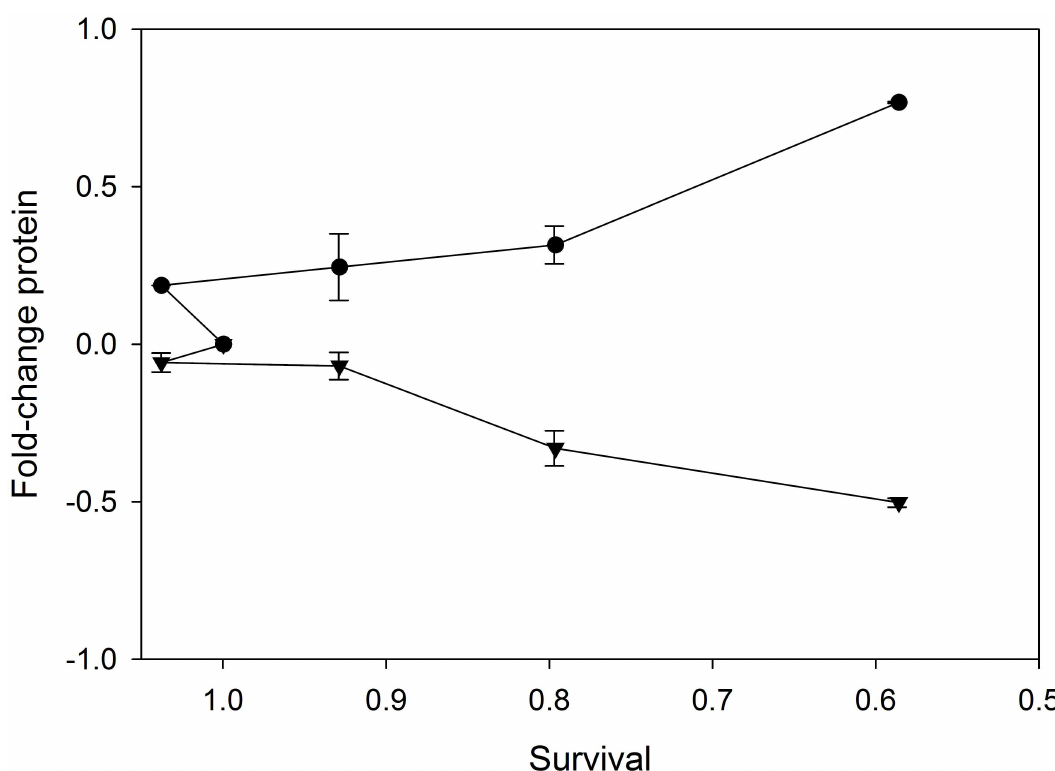
Fig 3. Relative cell survival (X-axis) vs. protein expression or phosphorylation levels (Y-axis)in BEAS-2Bcontrol cellstreatedwithNi (II)at 4 differentconcentrations. ● : IL-6; ▼ : JNK; A good linearcorrelationwas observedbetween IL-6 expression levels and cell survivalrates. Similarlinearcorrelation was observedbetweenJNK phosphorylationlevels and cell survivalrates (n = 3, p < 0.05).